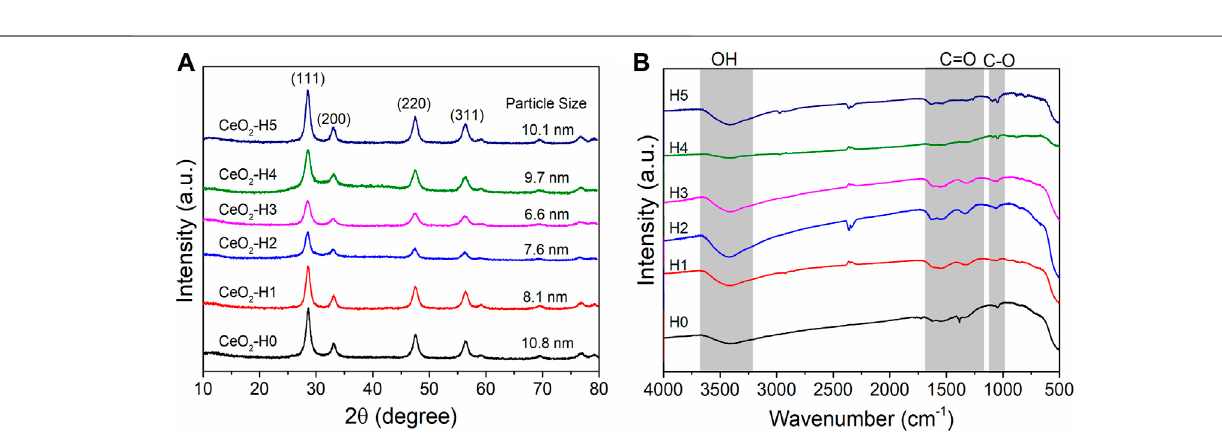
Frontiers in Chemistry |